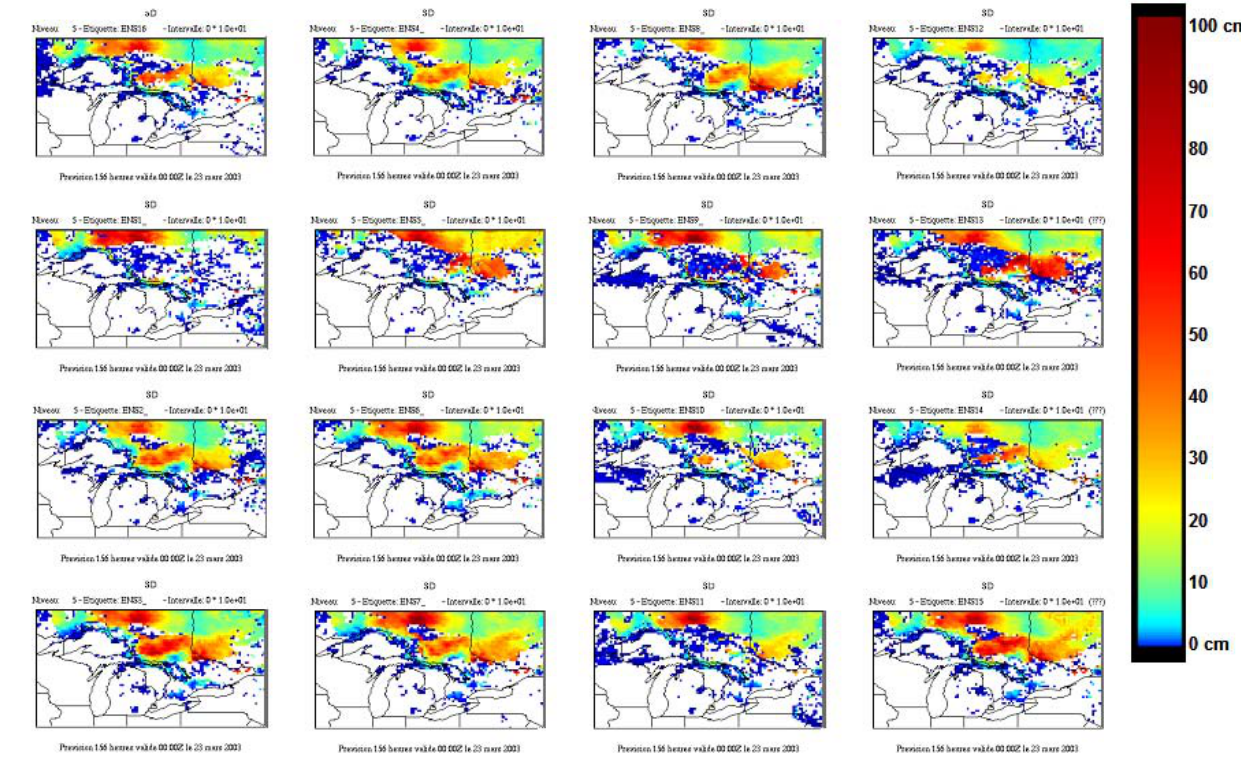
Fig. 18. Ensemble forecasts of snow depth issued on 16 March, valid on 23 March 2003.